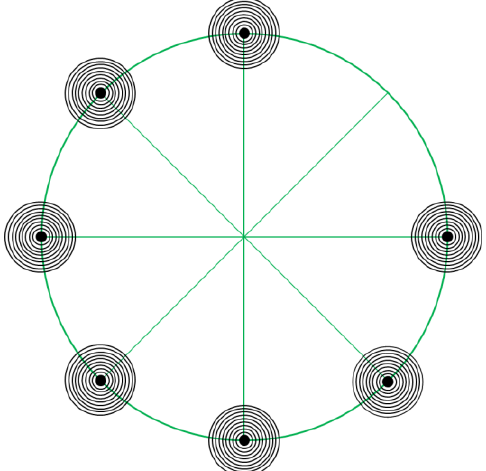
Figure 3. Characteristic diagram of the 10 N − 9 algorithm.